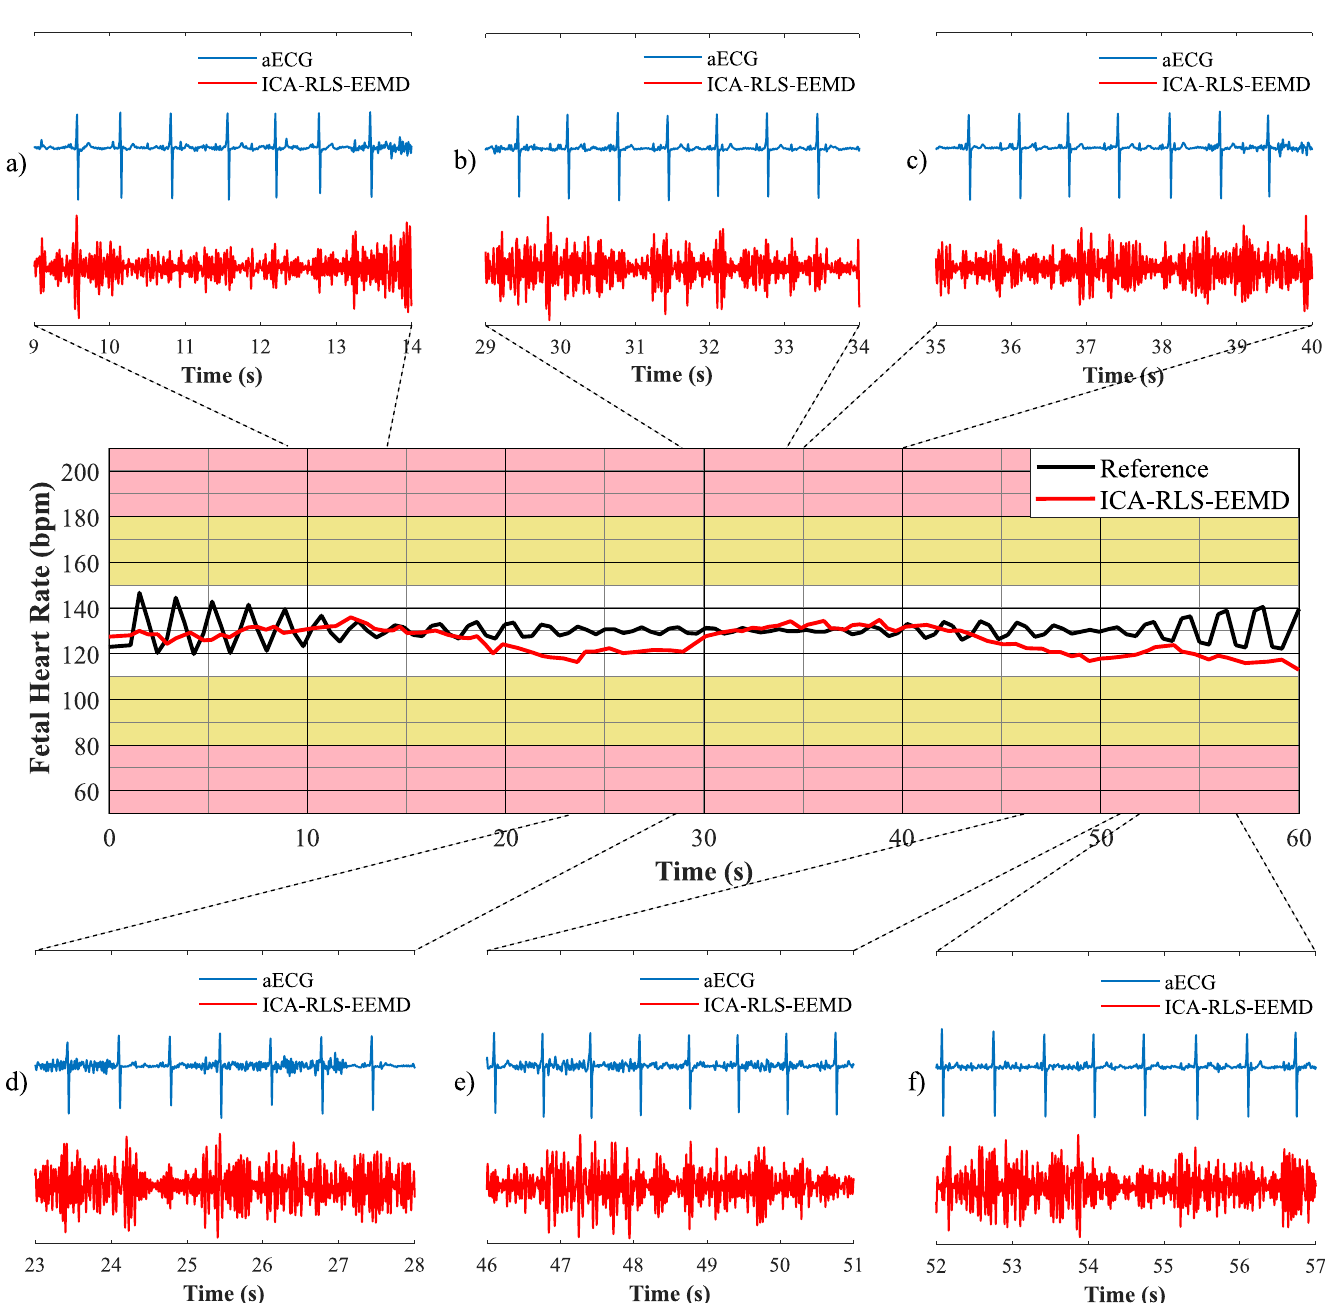
Fig 14. Illustration of the influence of the quality of aECG recordings on the final extraction and the fHR determination. As an example, the recording a16 from the Challenge database was selected, which was characterized by an overall low-quality extraction. Examples a), b) and c) correspond to signal sections where very low accuracy was achieved in the fHR determination, and examples d), e) and f) correspond to sections where the method failed completely when extracting the fHR.